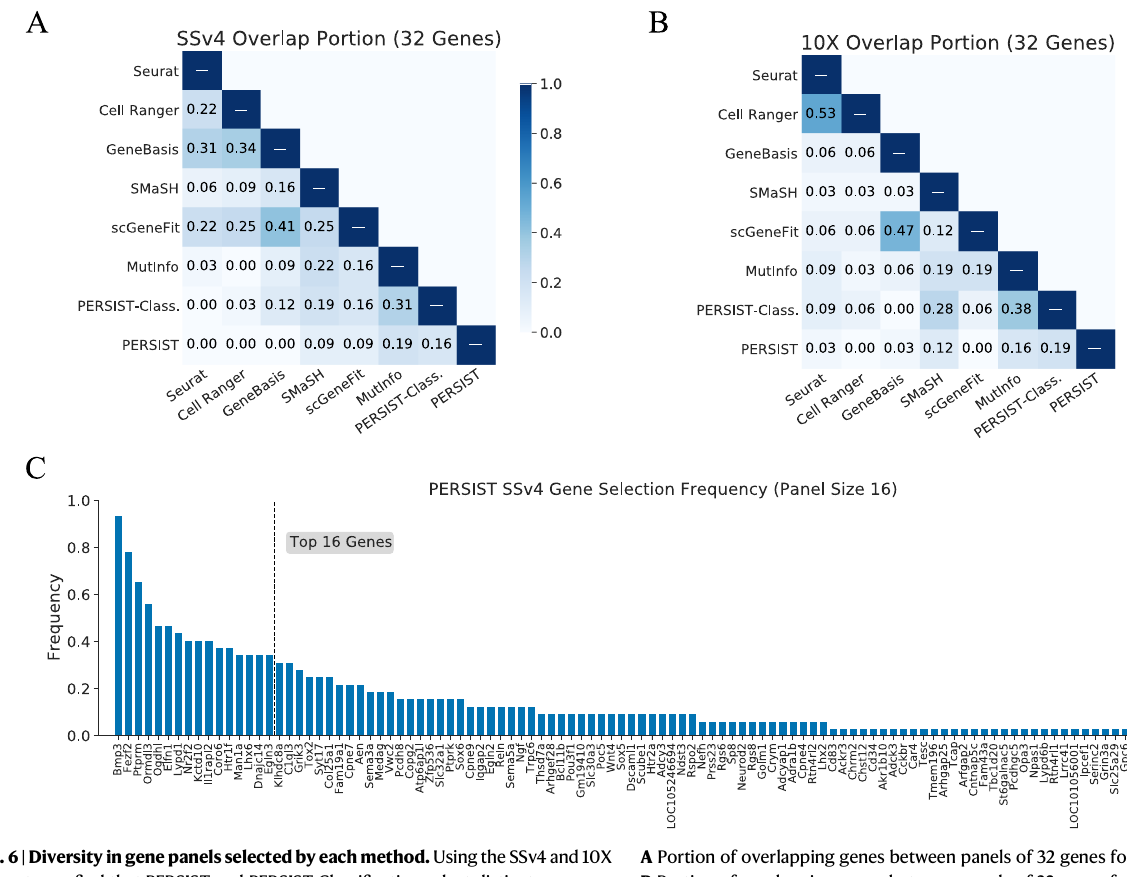
Fig.6|Diversityingenepanelsselectedbyeachmethod. UsingtheSSv4and10X datasets, we fi nd that PERSIST and PERSIST-Classi fi cation select distinct gene panels from prior methods. Additionally, because PERSIST is non-deterministic acrosstrials,we examinethefrequencyofitsgeneselectionsacrossmultipletrials.